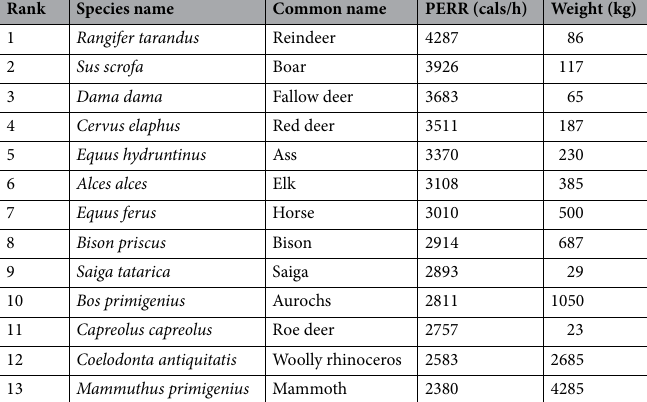
Table 1. Prey rank of the animal species used in the analysis, along with their body weight and calculated post-encounter return rate (PERR). Note that, as expected, body weight is not a reliable predictor for PERR as animal species such as aurochs, rhino, and mammoth rank tenth or lower when we consider their handling costs and probability of pursuit